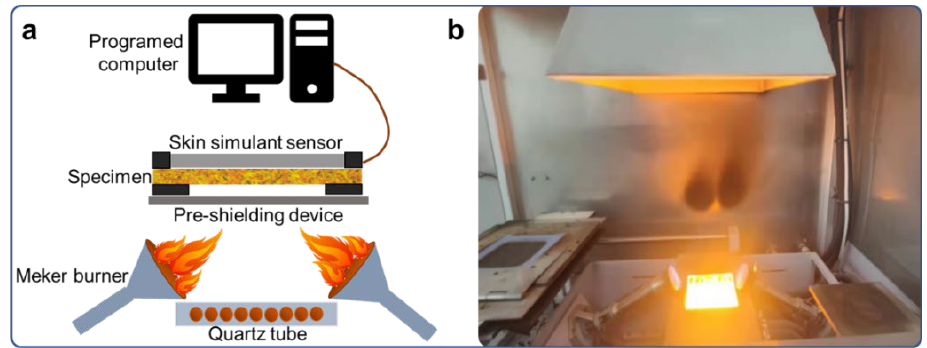
Figure 2. Test apparatus for TPP performance. ( a ) Schematic diagram. ( b ) Heat source apparatus under testing.